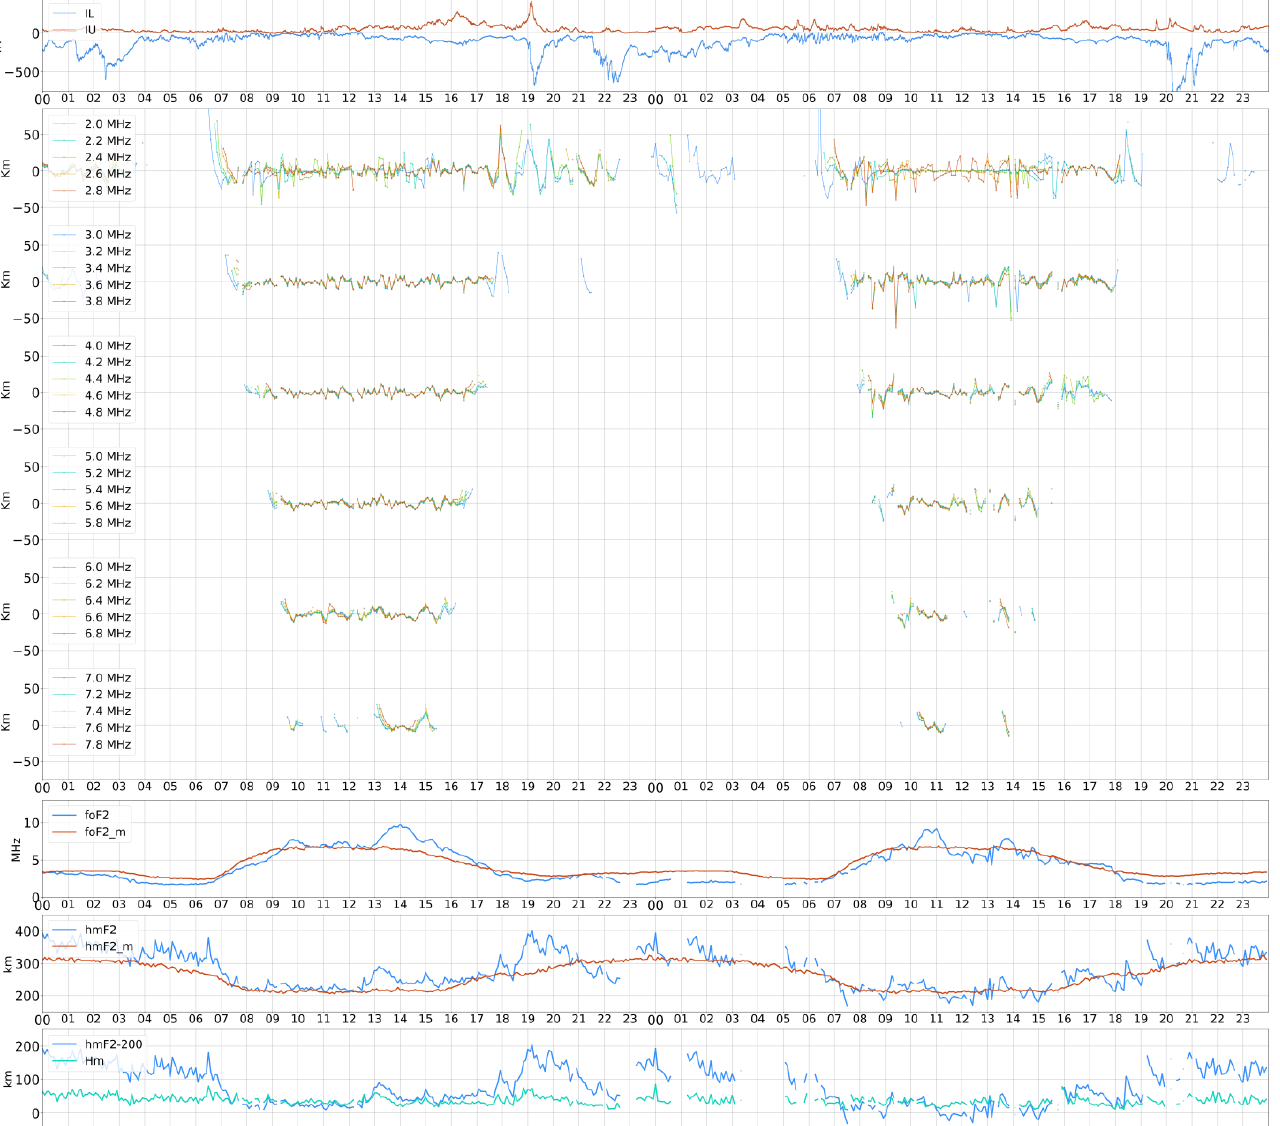
Figure 10. The same as Figure 9, for the Dourbes location. The analysis of this event provides evidence that the methodology proposed here has the capability to separate LSTIDs from MSTIDs. When TIDs are driven by auroral activity, the combined use of the three criteria indicates the existence of LSTID activity (during daytime hours, even though weak in this case). During the nighttime hours, when according to the literature MSTIDs occur, the combined use of the LSTID identification criteria results to no activity at